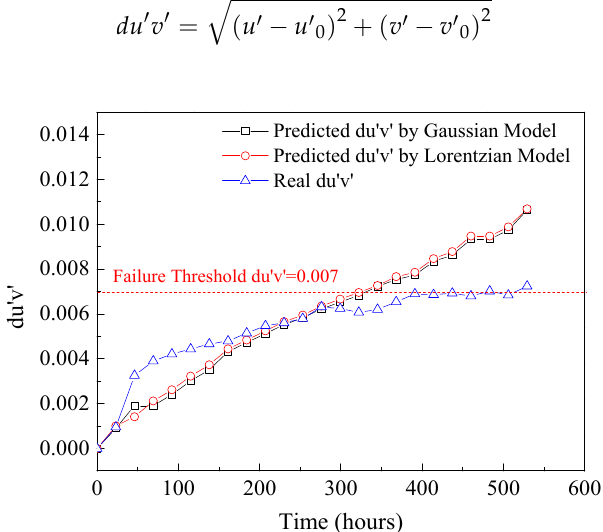
Figure 14. Prediction results of du ′ v ′ based on the Gaussian and Lorentzian models.